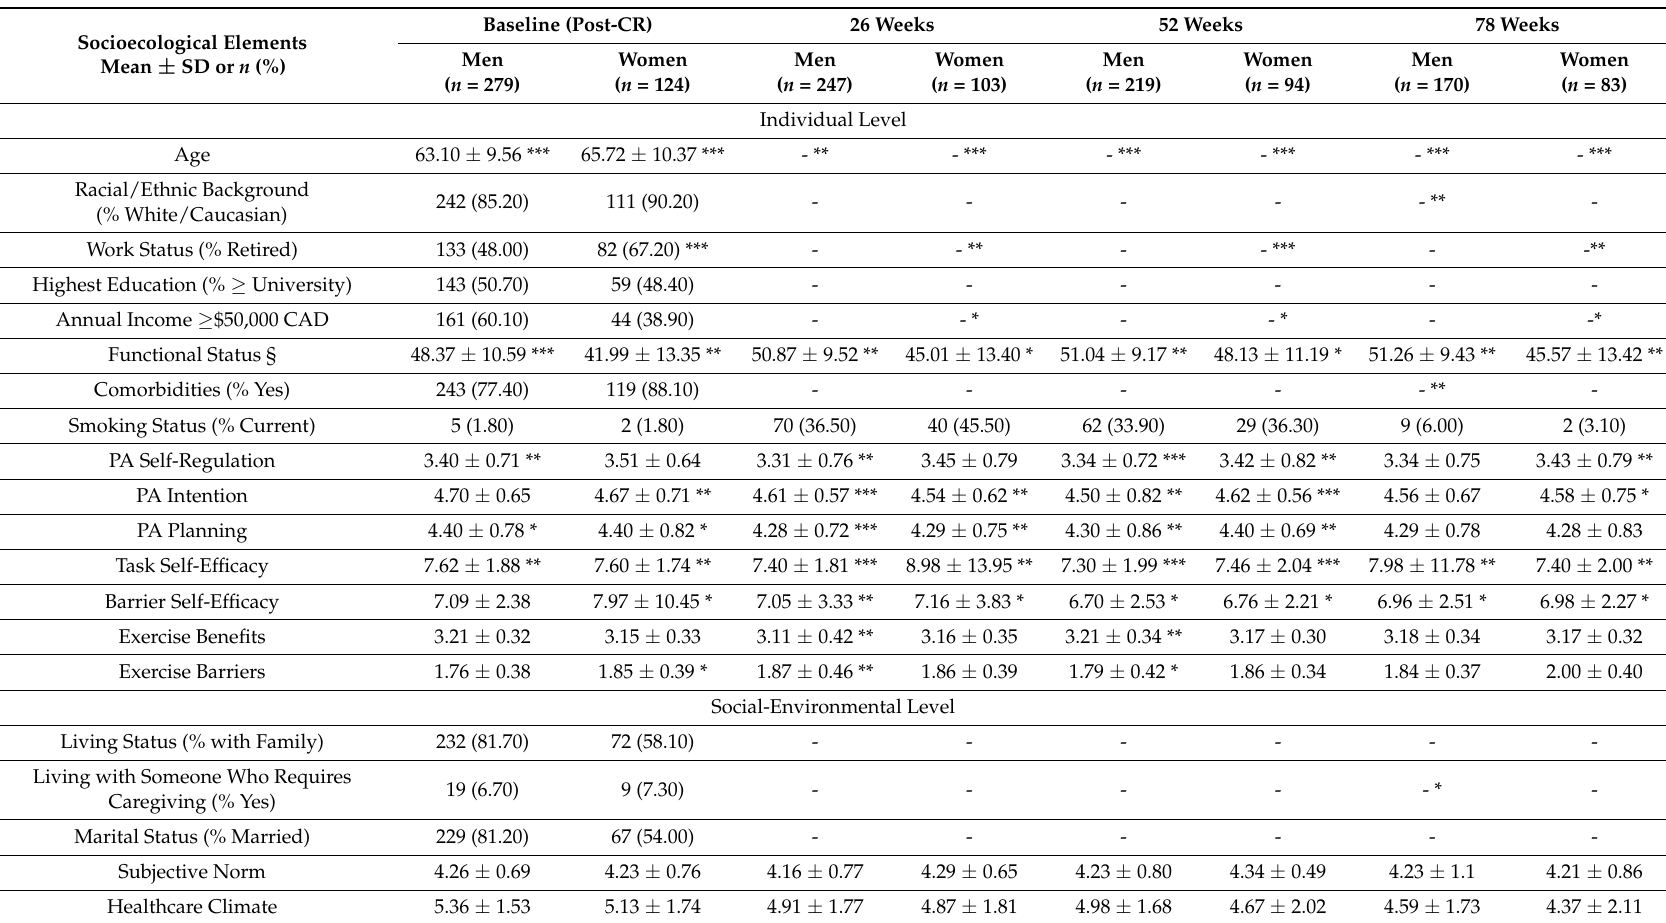
Table 3. Socioecological Elements, by Level, and Association with Moderate and Vigorous Intensity Physical Activity Through 1.5 Years Following Cardiac Rehabilitation Completion by